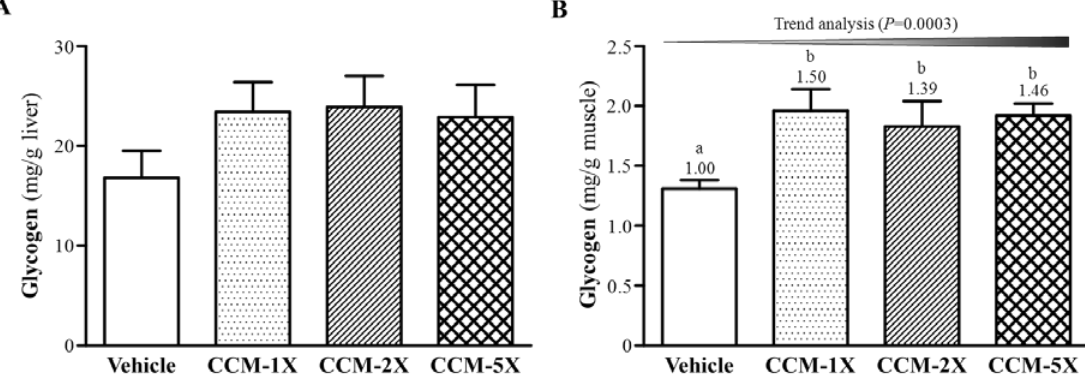
Figure 6. Effect of CCM supplementation on glycogen content in ( A ) liver and ( B ) muscle. Data are mean ± SEM for n = 10 mice in each group. Different letters indicate significant